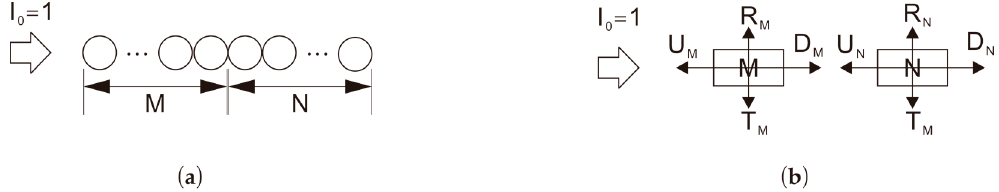
Figure 7. Schematic graphs of radiation transfer in a particle string. ( a ) the real situation when light incidents from the left along the string length; ( b ) a simplified graph of the system when taking M particles as a block and the other N particles as another block. The incident radiation ( I 0 ) is assumed to be a unit. U and D are the backscattering and forward scattering ratios of the particle string, respectively. R and T are the reflectance and transmittance of the particle string, respectively.